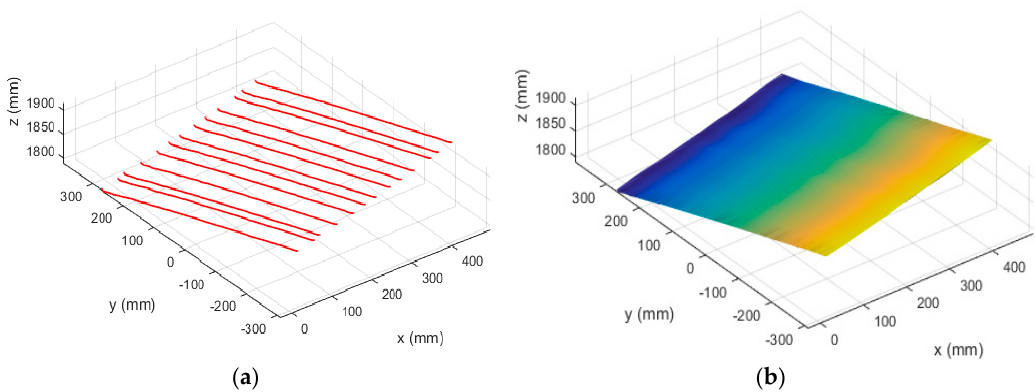
Figure 11. Reconstruction results of the flat calibration board after global optimization. Graph ( a ) shows the recovered positions of the light stripes in world coordinate system, and graph ( b ) shows the surface after triangulation and surface fitting. Table 3. Error from 3D points to the fitted plane.